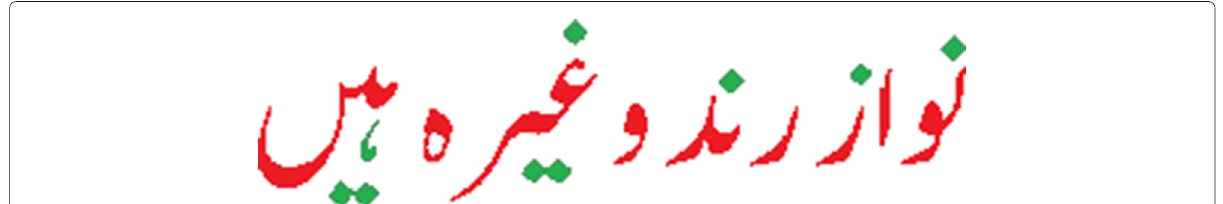
Fig. 10 Sample text line with ligatures identified as primary (red) and secondary (green) ligatures